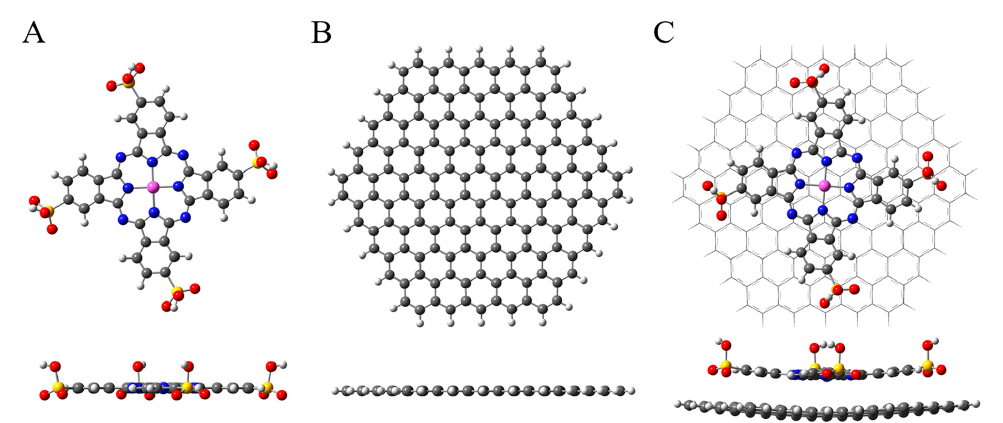
Figure 6. Fully optimized geometries of ( A ) PcS, ( B ) graphene, and ( C ) PcS–graphene nanohybrid. The purple, blue, yellow, red, black, and white balls represent Co, N, S, O, C, and H atoms, respectively.